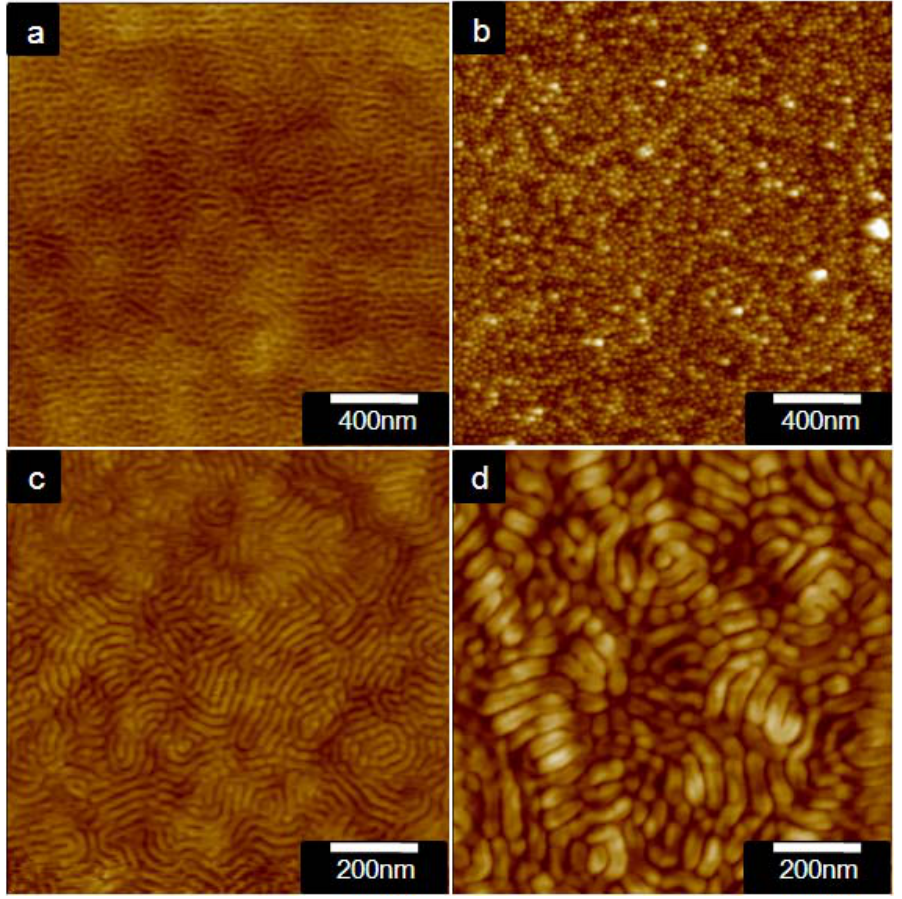
Figure S3. Height contrast AFM images of the surfaces of (a) PS- b -PEO/SiO containing 10 vol% inorganic precursors; (b) identical film in (a) after removing the BCP -TiO film containing 20 vol% inorganic precursors; templates; (c) PS- b -PEO/SiO 2 2 (d) identical film in (c) after removing the BCP templates. The hybrid films were prepared from spin coating dioxane solutions. Ti/Si mass ratio is